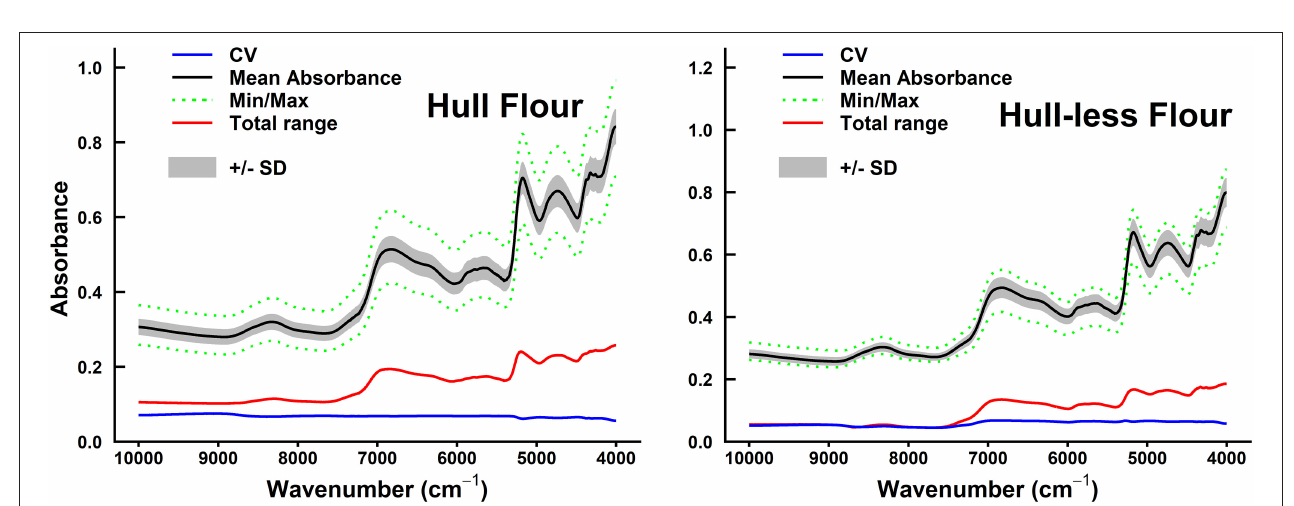
FIGURE 2 | Summary of spectral absorbance and characteristic wavelengths distribution measurements for sorghum whole grains vs. flours sample set ( n = 98). The range of coefficient variation (CV, blue line), mean absorbance (black line), minimum/maximum (green dotted line) spectral absorbance, total range of absorbance measurements (red line) for each wavelength (cm − 1 ), and SD + /– SD between sample sets were calculated.